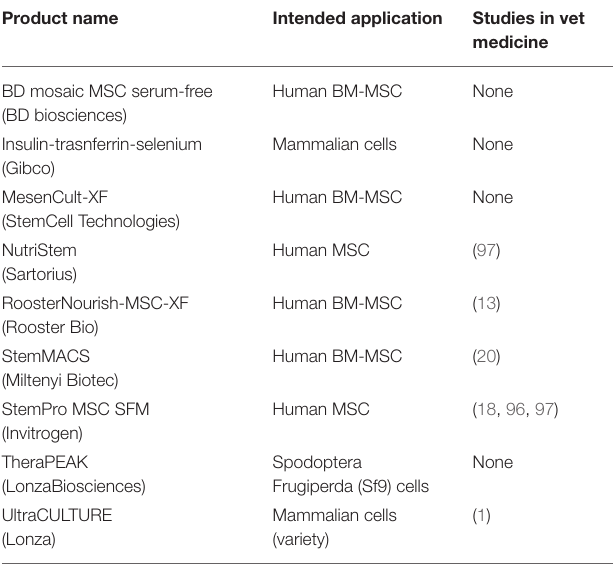
TABLE 3 | Commercially available SFM investigated in veterinary